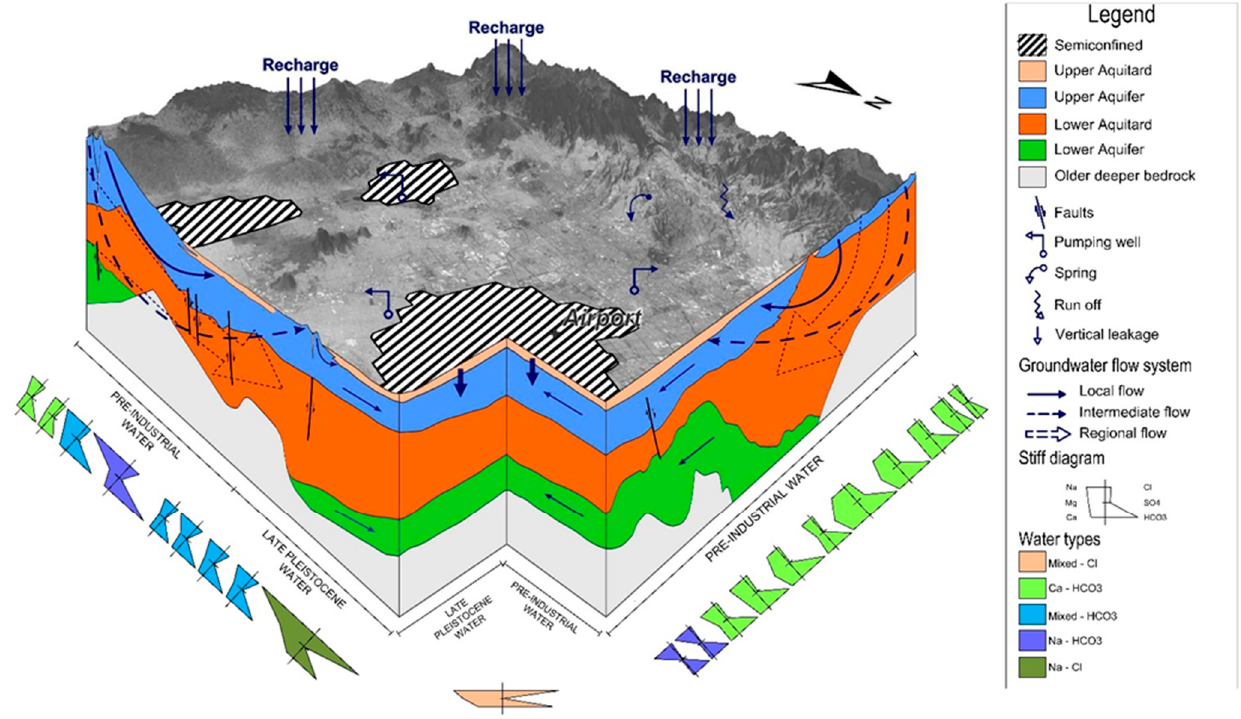
Figure 16. Three-dimensional conceptual model of the MBA combining results of the proposed 3D hydrogeological model (Figure 8) with the hydrogeochemical analysis based on cross sections C-C’ and D-D’ as shown in Figure 4.